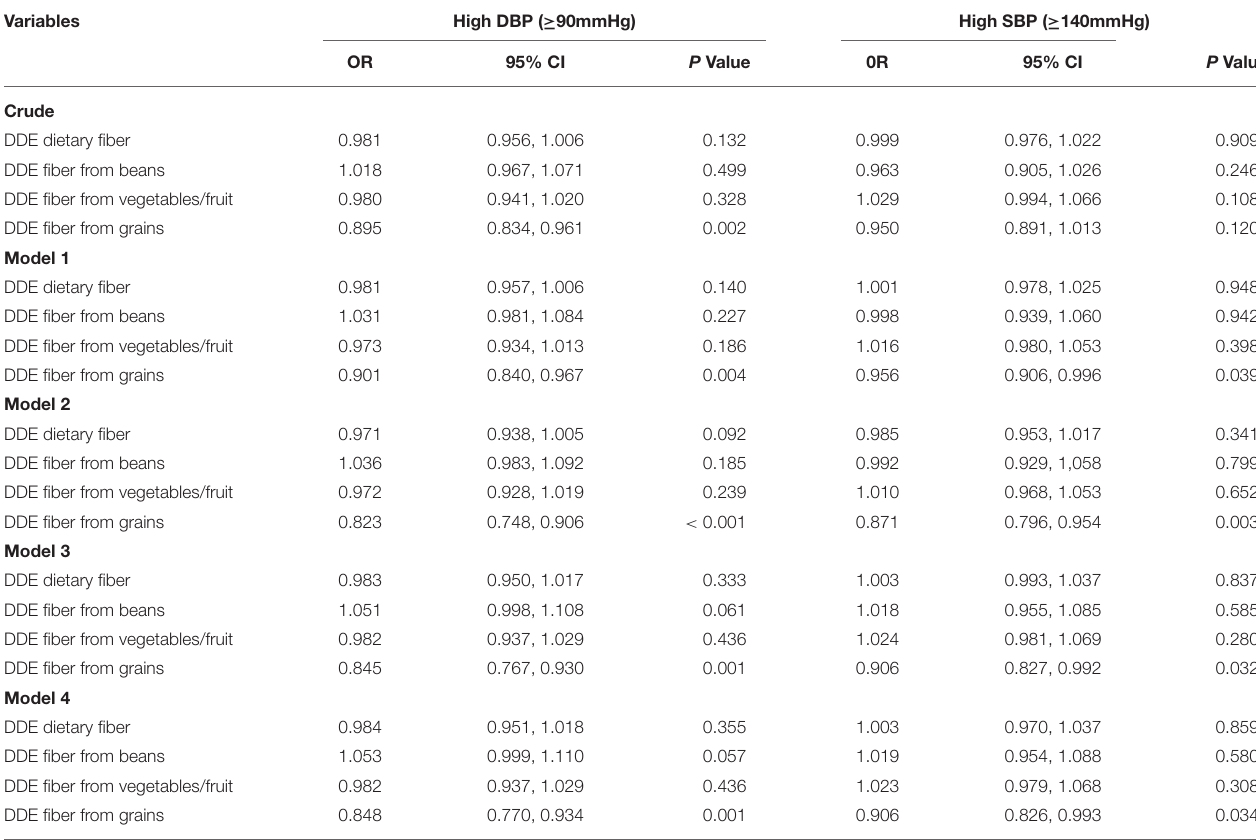
TABLE 3 | Multivariate logistic regression on association of DDE fiber and risk of hypertension. Variables